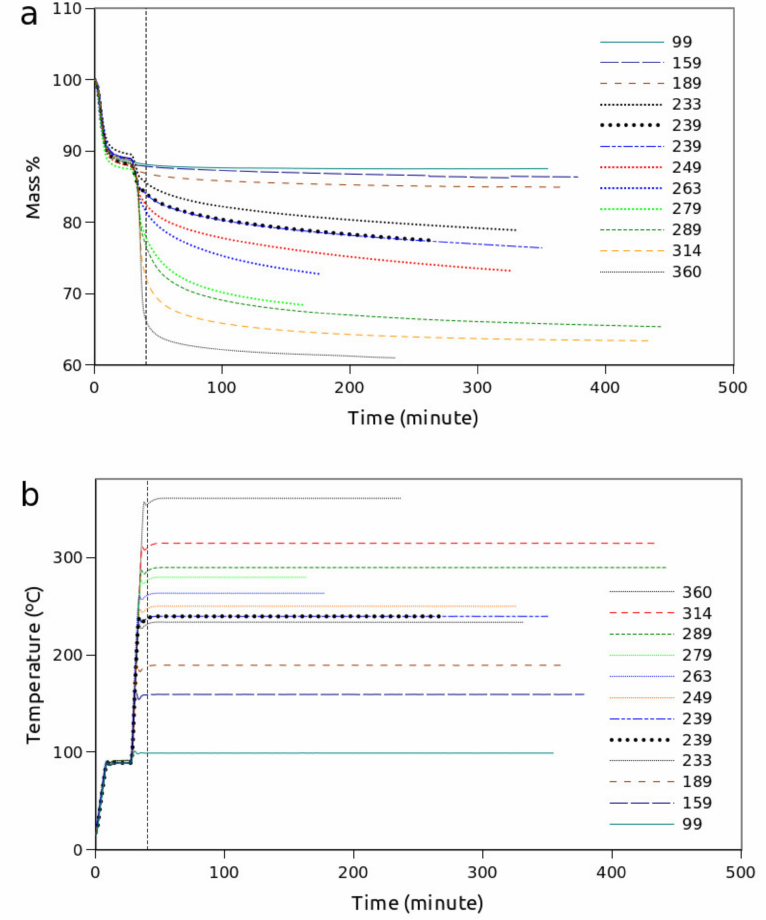
Figure 2. Overlays of TG ( a ) and temperature ( b ) curves obtained from 12 two-step isothermal